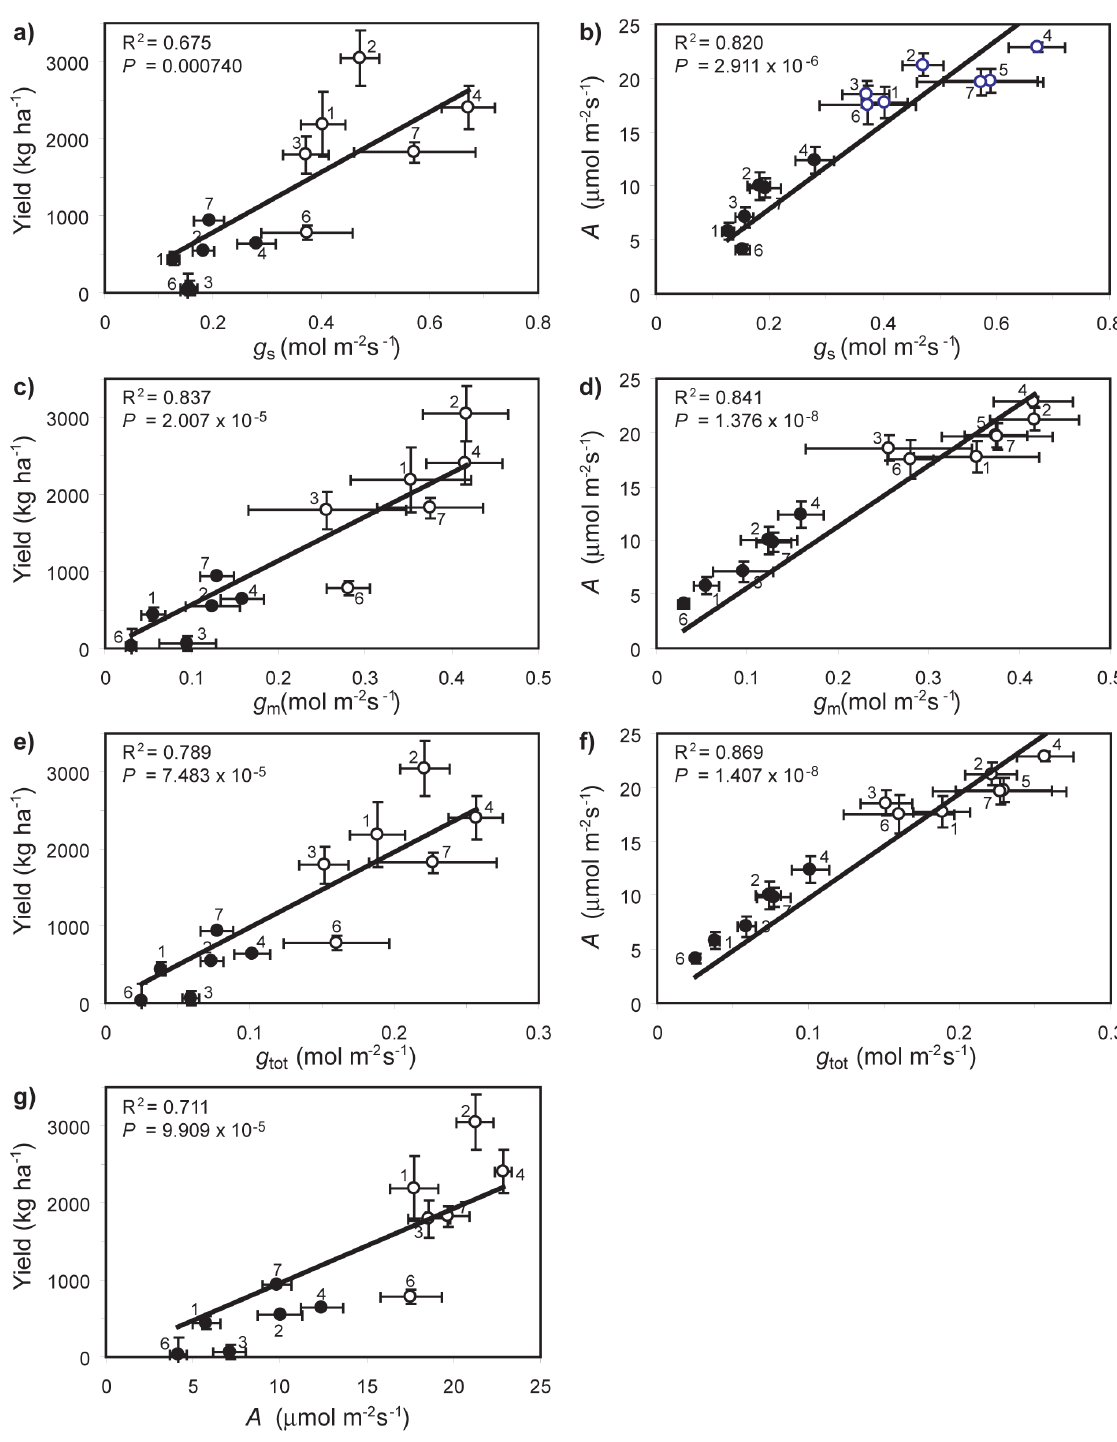
Figure 5. Interaction of diffusive conductance parameters to CO 2 uptake with yield and photosynthesis ( A ) under well-watered (open symbols) and drought conditions (closed symbols): a) relationship between yield and stomatal conductance ( g s ) (linear regression: R 2 =0.696; F 1,10 =22.900; P =0.000740); b) relationship between A and g s (linear regression: R 2 =0.873; F 1,11 =75.721; P =2.911 6 10 –6 ); c) relationship between yield and mesophyll conductance ( g m ) (linear regression: R 2 =0.850; F 1,10 =56.611; P =2.911 6 10 –5 ); d) relationship between A and g m (linear regression: R 2 =0.952; F 1,11 =217.071; P =1.376 6 10 –8 ); e) relationship between yield and total conductance ( g tot ) (linear regression: R 2 =0.806; F 1,10 =41.418; P =7.483 6 10 –5 ); f) relationship between A and g tot (linear regression: R 2 =0.952; F 1,11 =216.173; P =1.407 6 10 –8 ), and; g) relationship between yield and A (linear regression: R 2 =0.795; F 1,10 =38.665; P =9.909 6 10 –5 ). Error bars as in Figure 1. Numbers next to data points indicate Oryza sativa variety as in Figure 1.